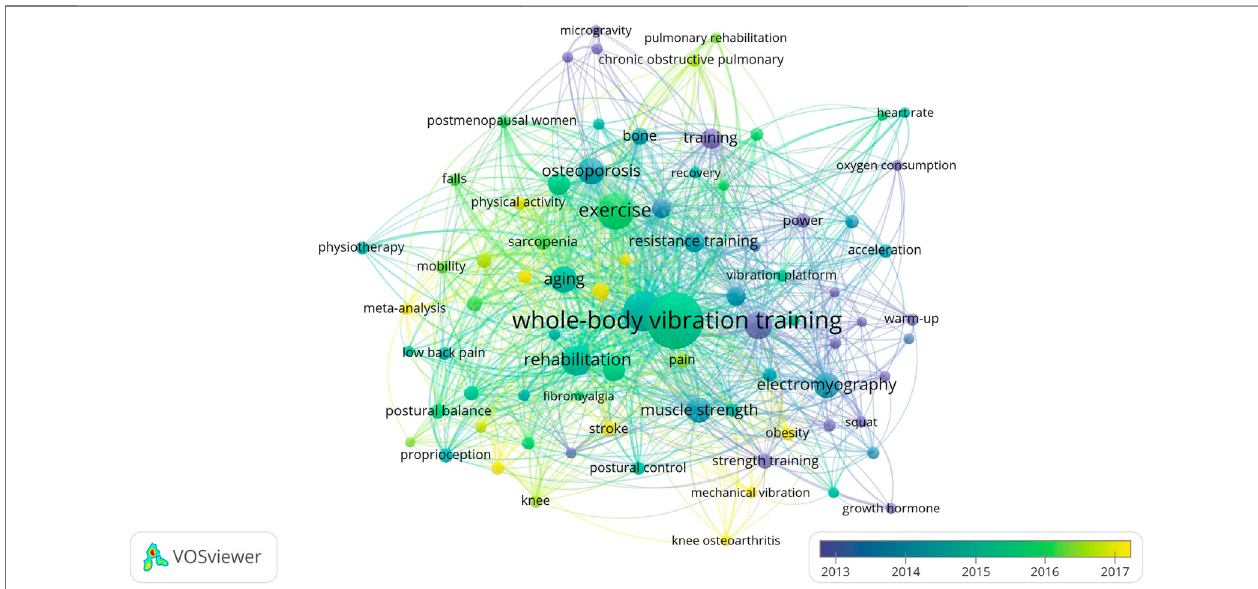
FIGURE 7 | Co-occurrence clustering network of keyword – time dual-map in the research of WBVT.